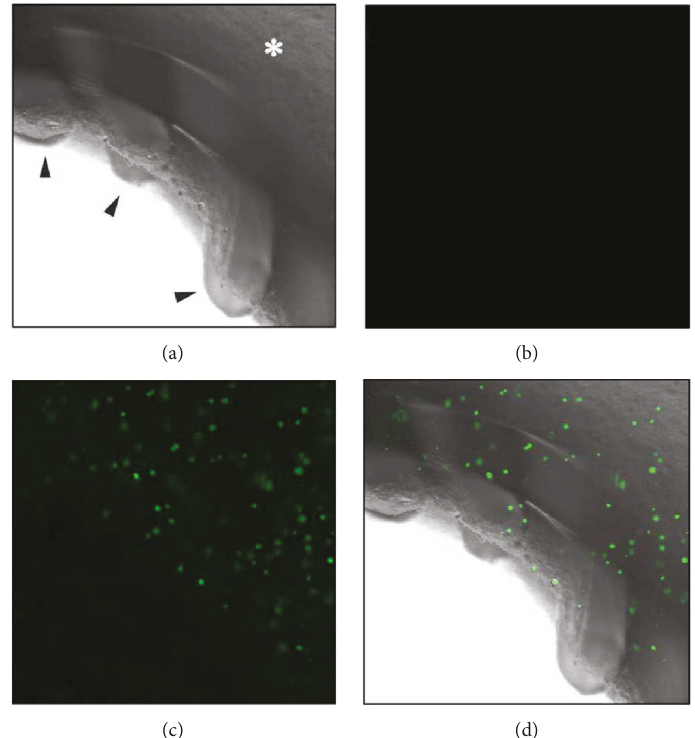
Figure 8: Confocal microscopic image of endothelial-like cell engraftment into the arti fi cial vessel lumen. The inner side of the pumped tube had PCL structures in a cross-striped pattern (black head arrow). There are some live cells (green) (c) and no dead cells (red) (b) in the sodium alginate hydrogel layer (white asterisk). Live cells had engrafted into the lumen